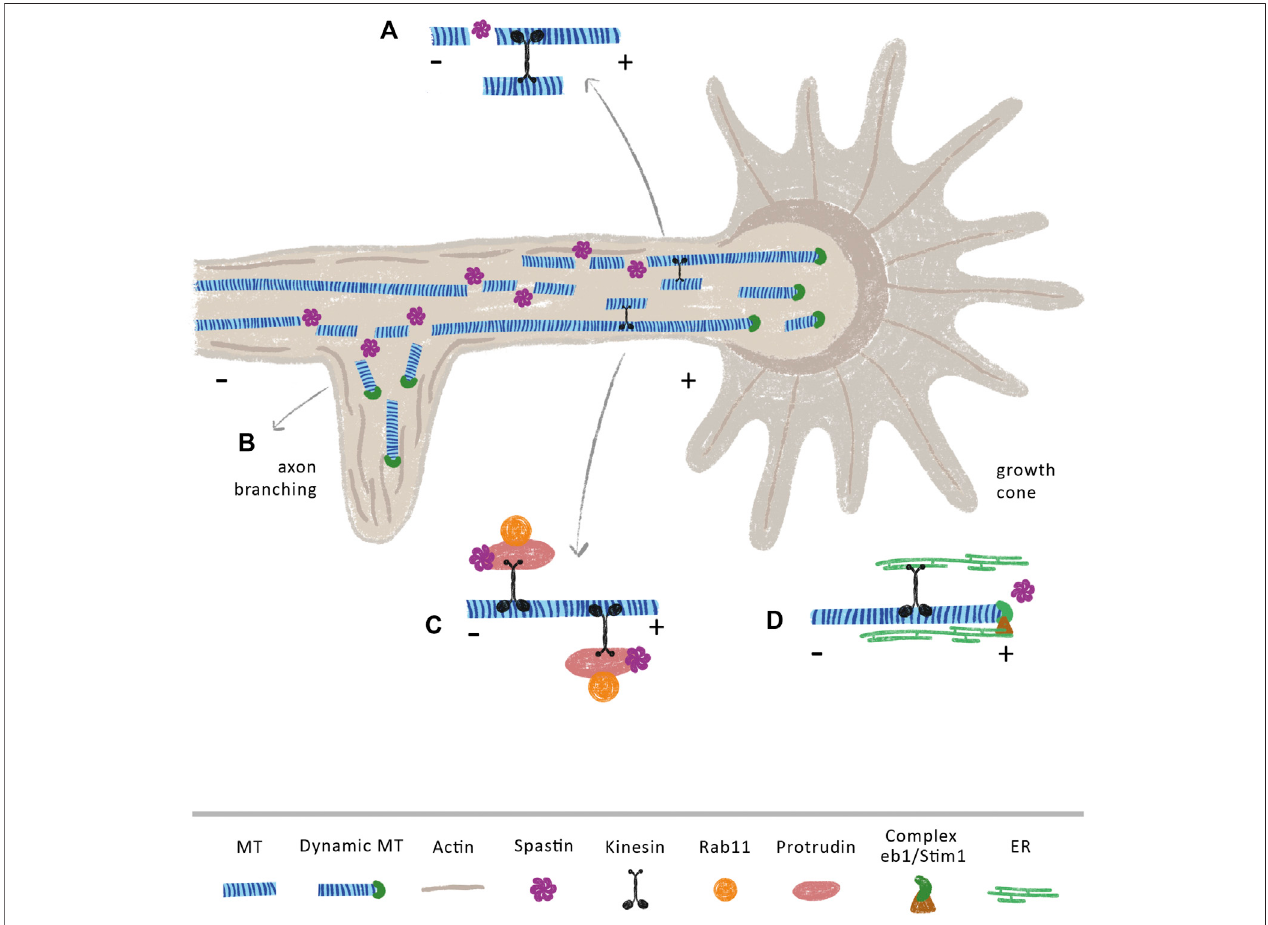
FIGURE 3 | Spastin modulates axon branching and (re)growth through MT dependent and independent mechanisms. Spastin severing activity may increase the availability of short and dynamic MTs that are anterogradely transported towards (A) growth cones and (B) axonal branches, supporting axon elongation at these sites. Ofnote,spastinishighlyconcentratedatthesesites(Yuetal.,2008) (C) Spastinregulatesthetransportofthegrowth-relatedmoleculeRab11byinteractingwiththeER protein protrudin. In CNS,overexpression ofprotrudin leadstorobust CNS regeneration(Petrova et al.,2020) (D) The movement ofERthroughthe tipattachment complexismediatedbythebindingofERtotheproteincomplexSTIM1andEB1attheplus-tipofMTs.Uponinjury,theERaccumulatesatgrowthconesofregenerating axons(Raoetal.,2016).Weproposethatanincreaseofspastinafterinjury,mayincreasethenumberofMTplus-tips,whichmightunderlietheincrementinthetransport of ER to these axonal